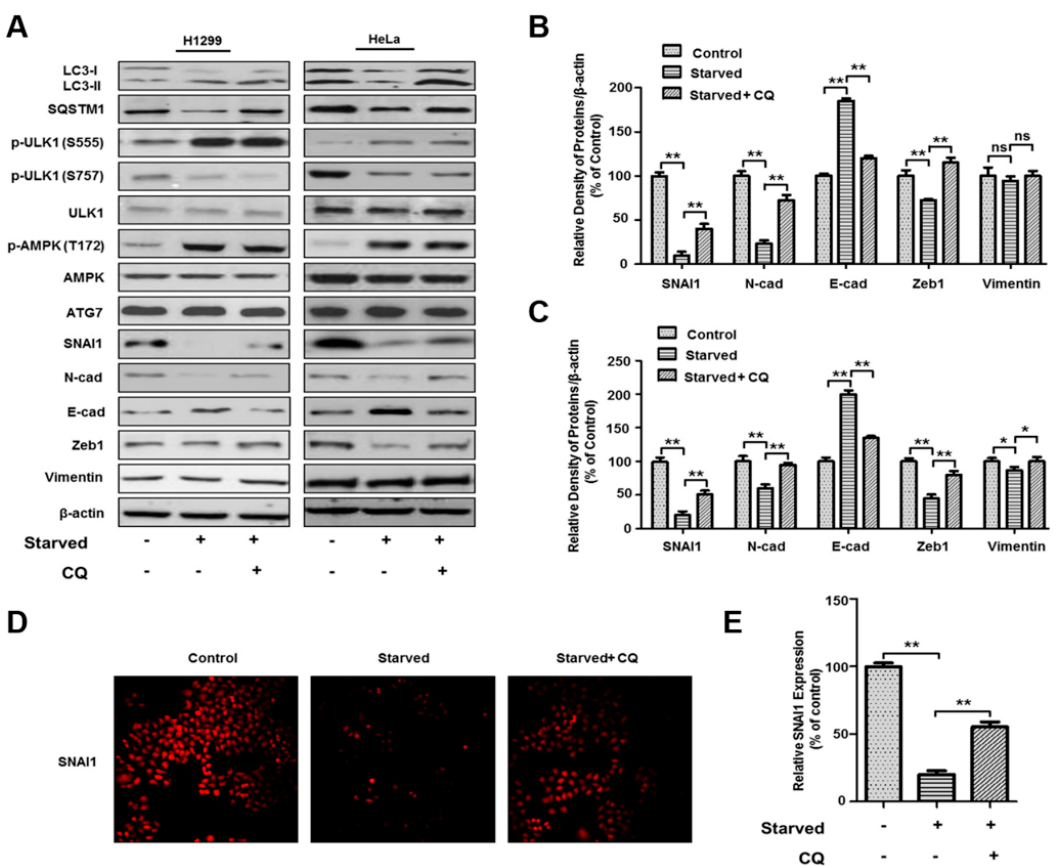
Figure 3. Autophagy-induced SNAI1 degradation is associated with the expression of EMT- and cancer metastasis-related proteins. ( A ) H1299 (left) and HeLa (right) cells were starved with HBSS for 4 h in the presence or absence of 20 µ M chloroquine (CQ). After lysis, total-cell extracts (30 µ g) were separated by 10% or 12 % SDS-PAGE and analyzed by western blotting using primary antibodies against LC3, SQSTM1, p-ULK1-S555, p-ULK1-S757, p-AMPK-T172, AMPK, p-mTOR-S2248, mTOR, SNAI1, N-cadherin, E-cadherin, Zeb1, and vimentin. β -actin was used as a loading control. ( B , C ) The levels of each EMT-related protein (SNAI1, N-cadherin, Zeb1, and vimentin) in H1299 (B) or HeLa ( C ) cells were quantified using NIH ImageJ software. β -actin was used as a loading control. Data represent the mean ( ± S.D.) of three independent experiments (* p < 0.05 and ** p < 0.01). ( C , D ) Immunocytochemistry of SNAI1. HeLa cells were treated with HBSS with or without 20 µ M CQ for 4 h. The expression levels of SNAI1 (red) in cells were determined by immunocytochemistry ( C ). Images were captured from at least 20 different areas by florescence microscopy (Olympus BX51-DSU), and the immunofluorescence of SNAI1 was quantified using NIH ImageJ software ( D ). Data represent the mean ( ± S.D.) of three independent experiments (** p < 0.01).